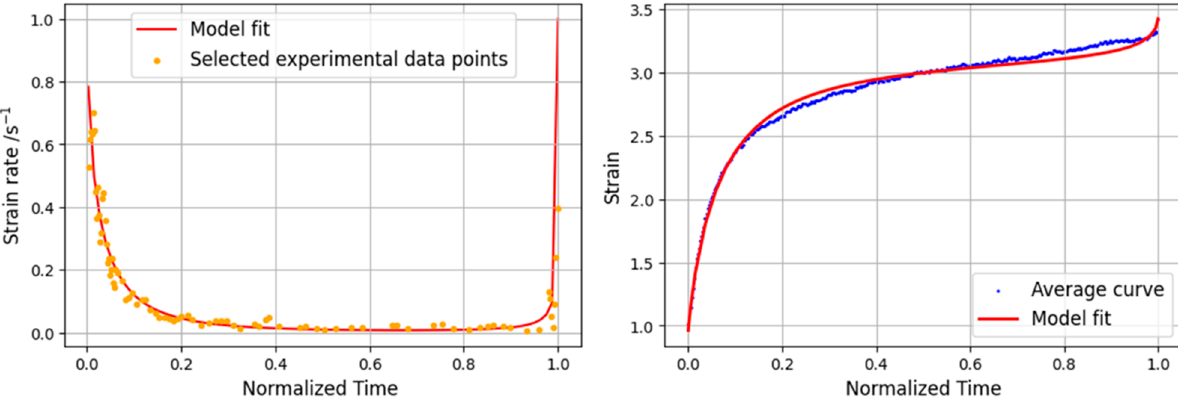
Figure 13. Analytical and experimental strain rate curve ( left ) and static creep curve ( right ) for 60% load level. For the 30% load level, the reduction in the order of magnitude of the strain rate values is evident. This behavior is consistent with a duration more than 50 times longer than the other load levels, resulting in a progressive evolution of the creep curve, with a very large secondary phase. Due to the very high value of the initial slope of the experimental curve, the analytical model encountered some difficulties in approaching the initial value of the strain; although, in the rest of the curve, the correlation is very high. These problems occurred because the model resorts to an exponential equation, and when the initial slope is too high, the transition from primary to secondary creep is difficult to